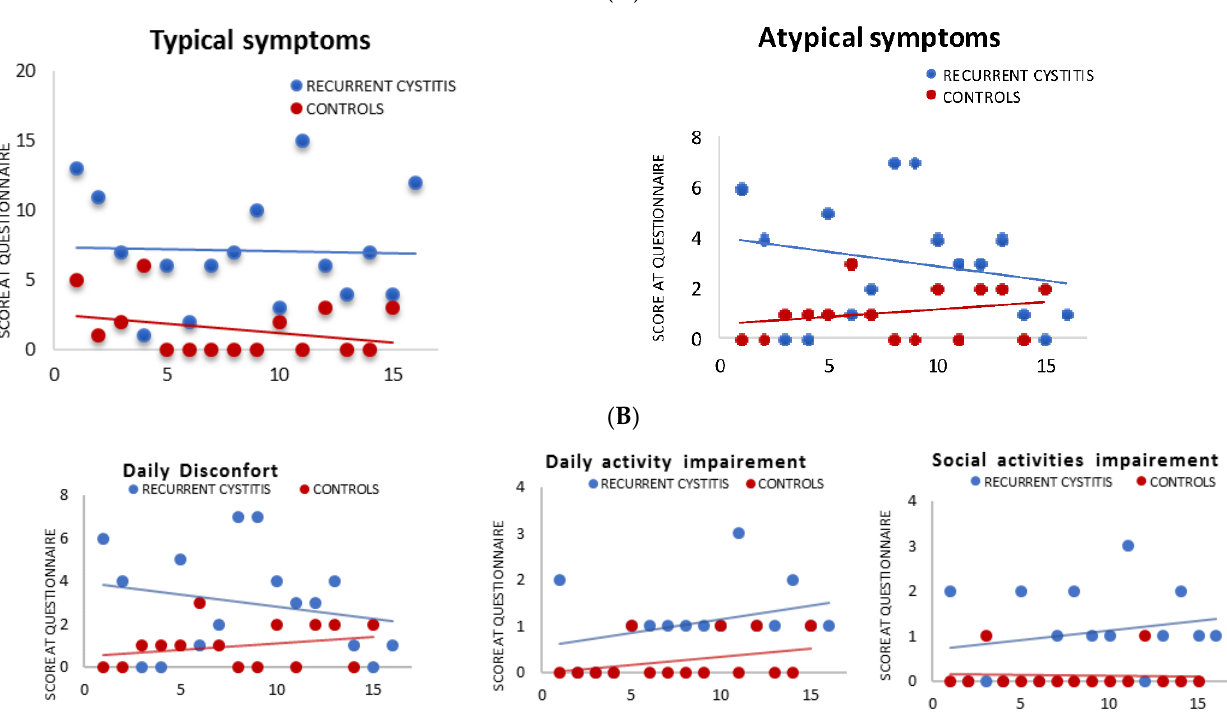
Figure 1. Symptoms and quality of life impairment in patients affected by RC (cohort I): ACSS/UTISA scores. ( A ) ACUTE CYSTITIS SYMPTOM SCORE (ACSS) AND UTI SYMPTOM ASSESSMENT (UTISA); ( B ) SELECTED ITEMS FROM ACSS/UTISA QUESTIONNAIRE. Patients with recurrent cystitis showed higher scores for the questionnaires compared to controls, both in the area of typical and atypical symptoms ( A ) Similarly, they scored significantly higher in items evaluating the perceived impact on quality of life. Selected items are reported in ( B ). All the differences were statistically significant ( p < 0.05).